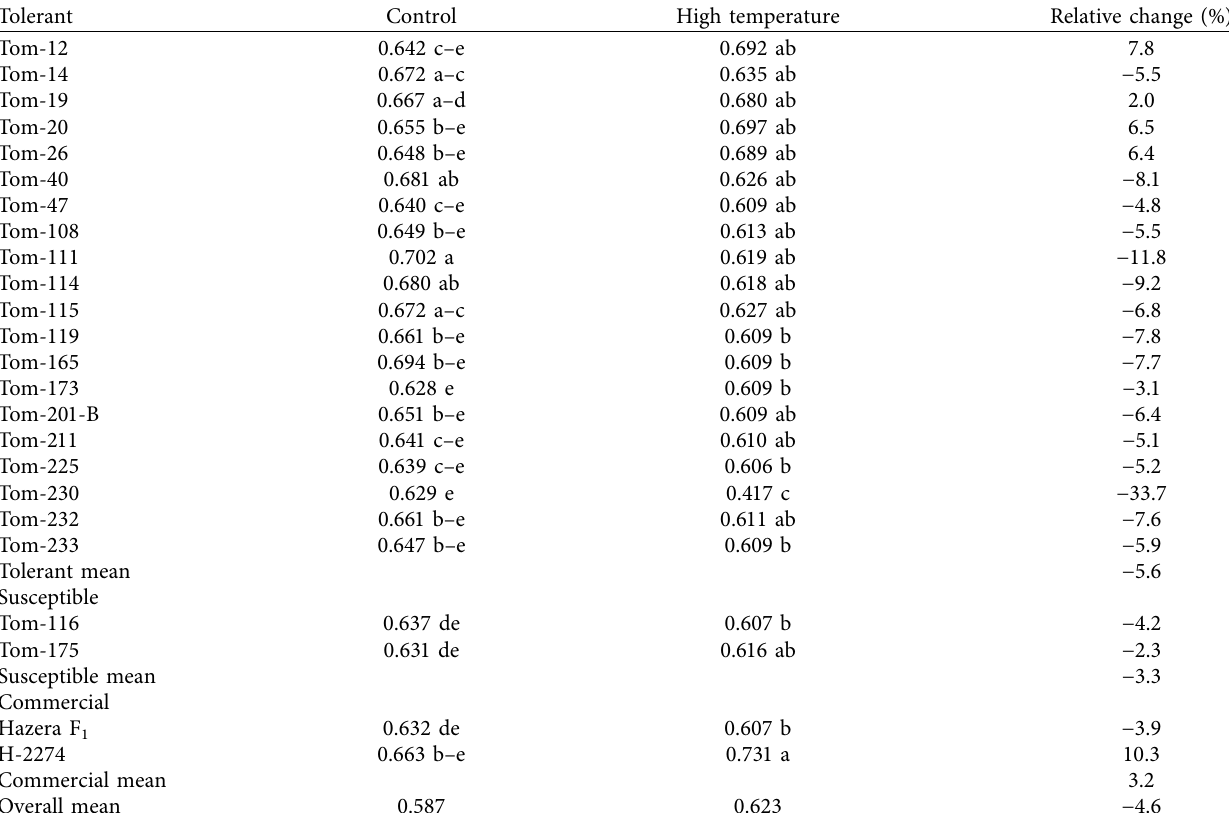
Table 11: β -carotene content of tomato fruits grown in control and high temperatures (mg/100 g